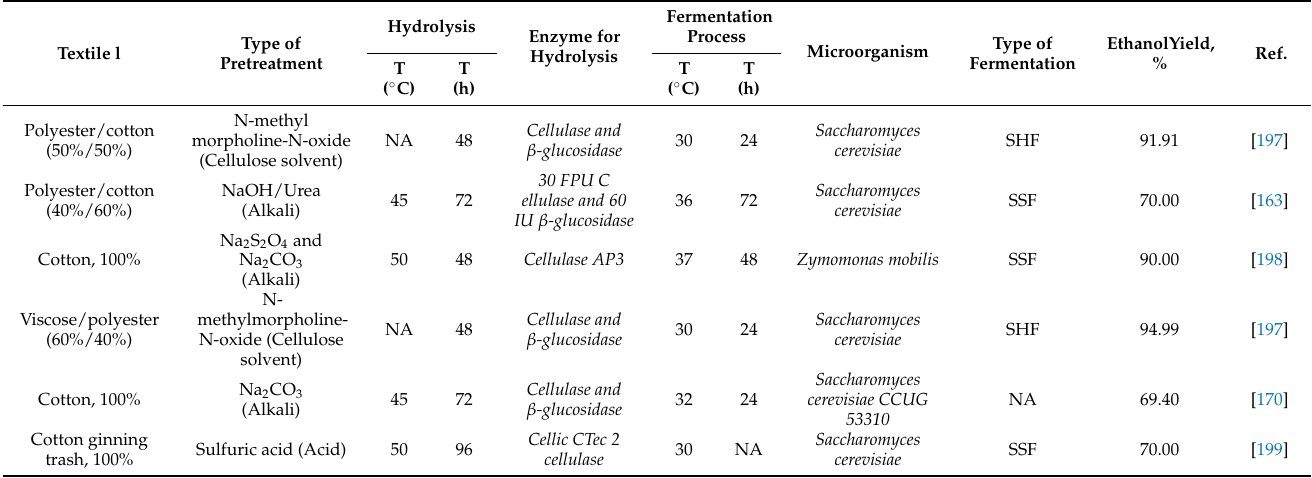
Table 6. Ethanol production after enzymatic hydrolysis and microorganism fermentation of textile wastes.